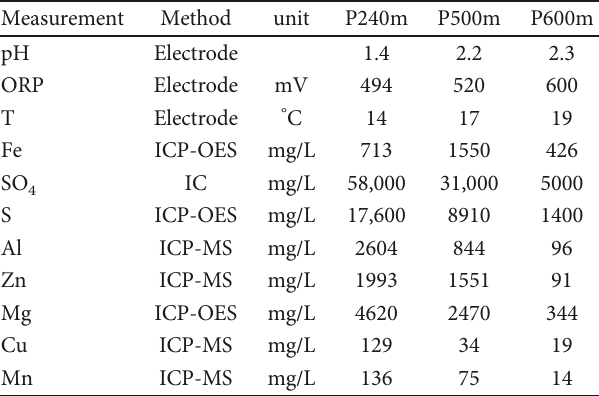
Table 2: The physicochemical parameters and the concentration of the most important elements and sulphate measured from the original mine water